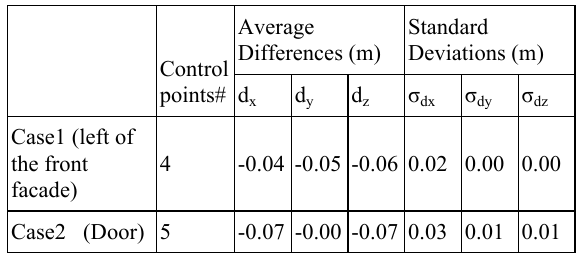
Table 1. Differences on the control points after applying ICP to the georeferenced point